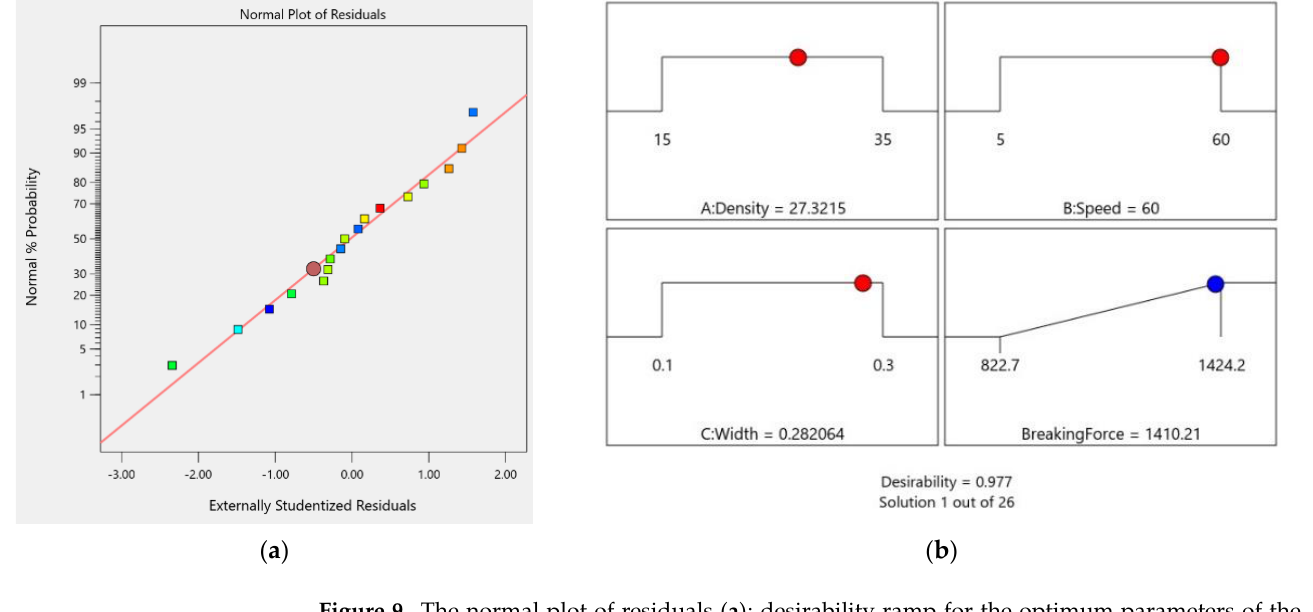
Figure 9. The normal plot of residuals ( a ); desirability ramp for the optimum parameters of the DoE ( b ).